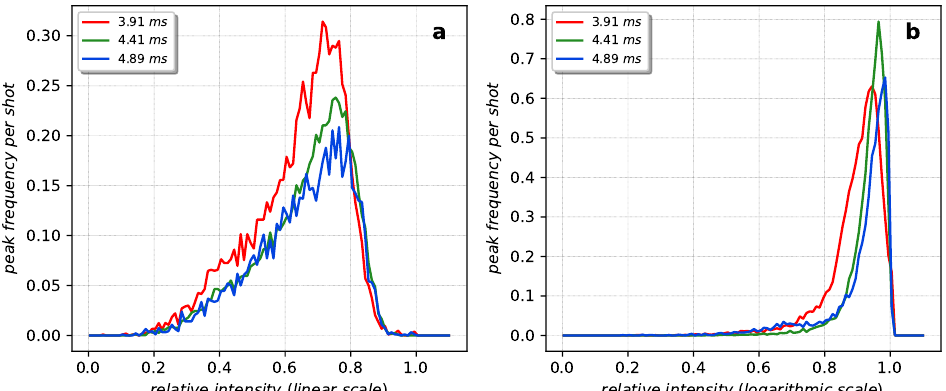
Figure A1. Frequency of relative intensity of local maxima within a peak region for the hits above 50 ADU/pixel (full Q -range) in ( a ) linear and ( b ) logarithmic intensity scales.